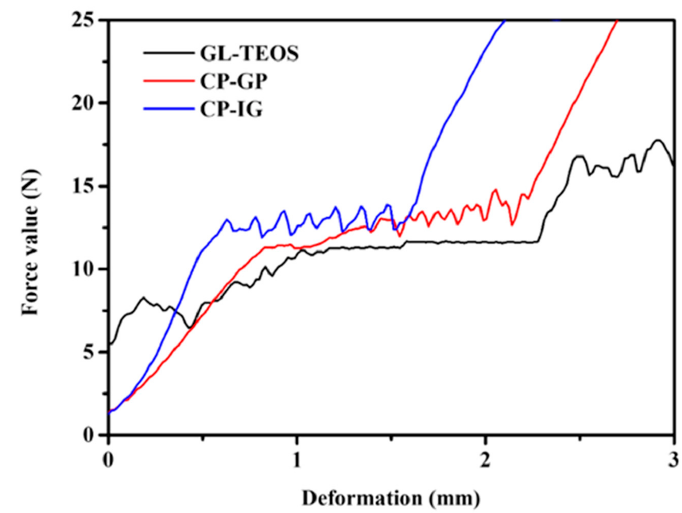
Figure 8. Compression test curve of GL-TEOS, CP-GP, and CP-IG.